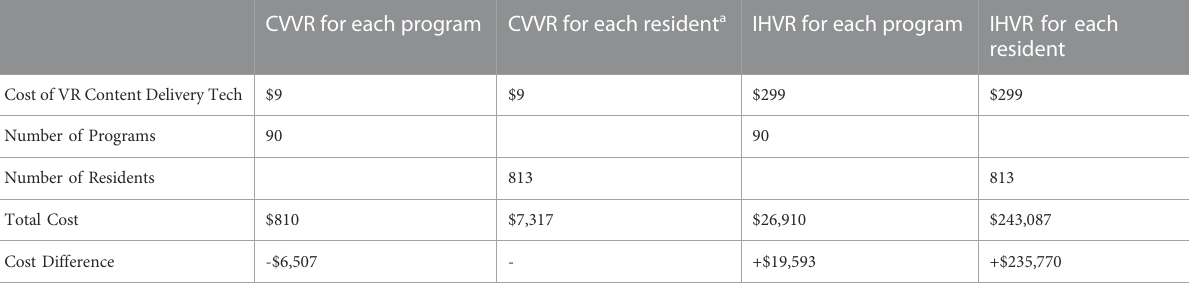
TABLE 3 Cost of virtual reality delivery platform for residency training. CVVR for each